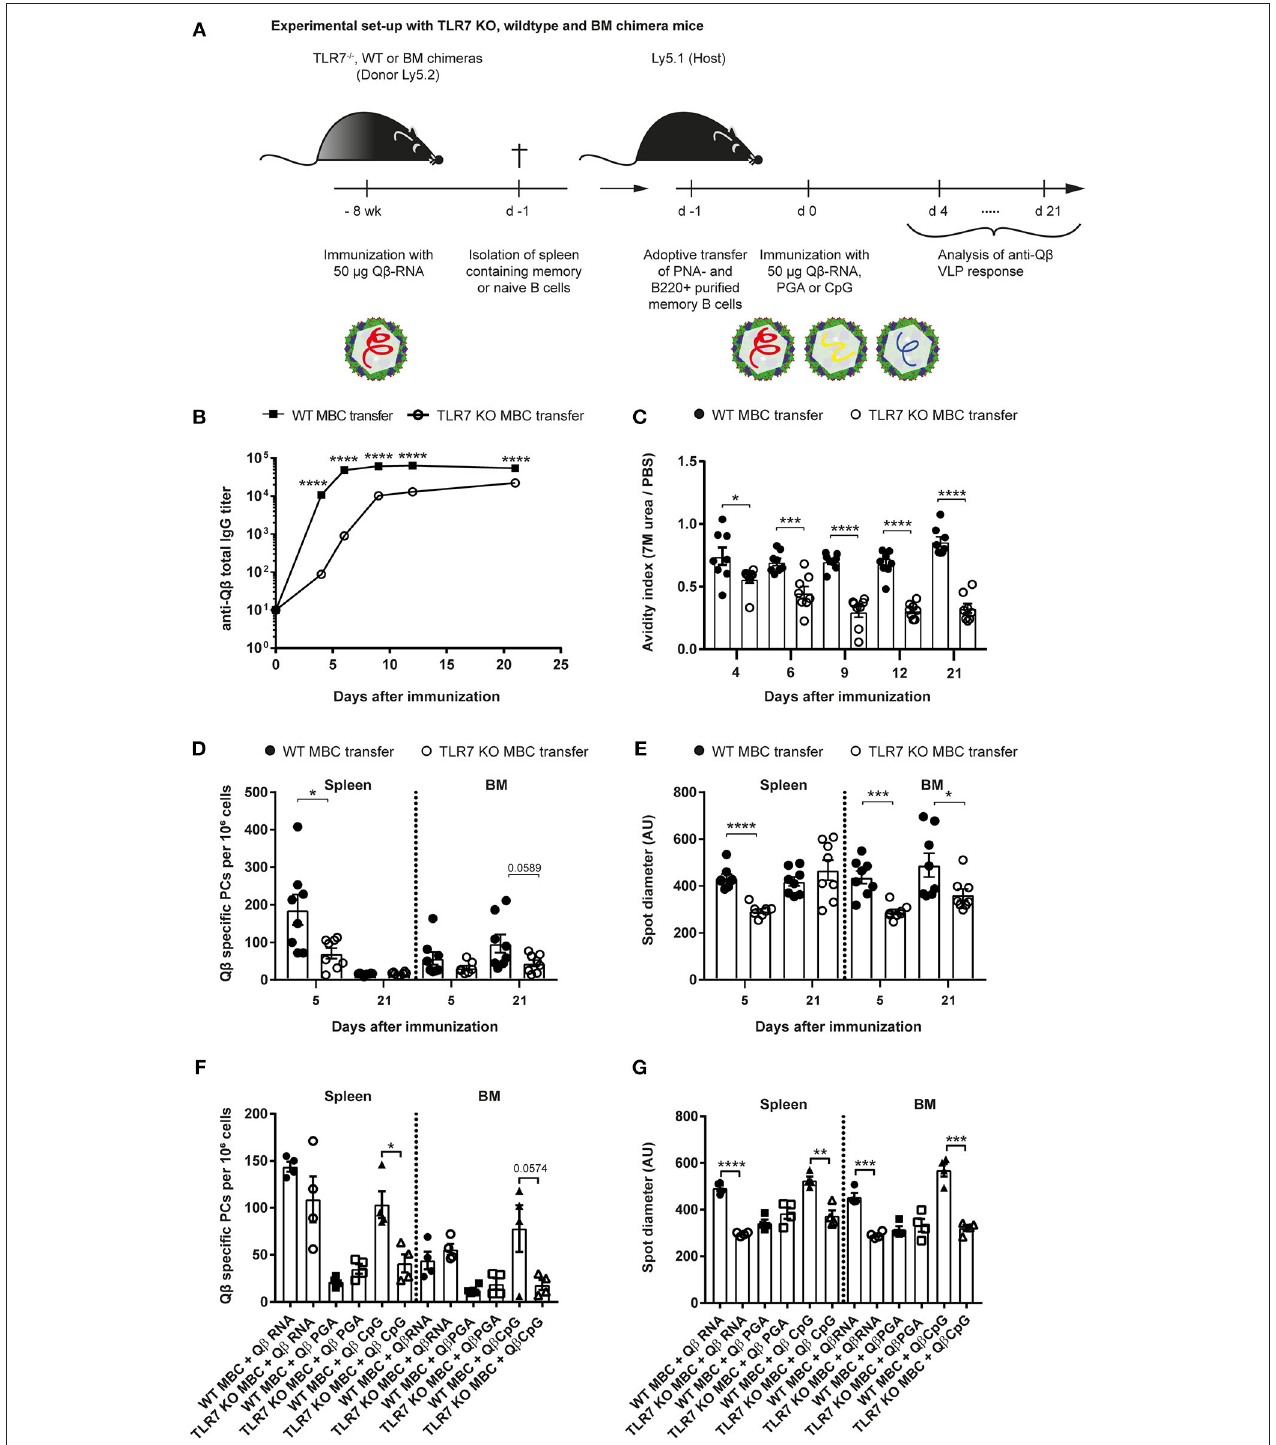
FIGURE 3 | TLR7 must be present during memory B cell induction to generate secondary PCs after challenge with VLPs. (A) Memory B cells were induced in TLR7 KO, WT, or BM chimeras by immunization with 50 µ g Q β -RNA i.v. Eight weeks after immunization spleens were isolated and PNA − B220 + MACS purified cells were transferred into host mice (Ly5.1). One day after the transfer, recipient mice were challenged with 50 µ g Q β -RNA (B–E) or Q β -RNA, Q β -PGA, and Q β -CpG (F,G) i.v. Spleens, bone marrow, and serum were taken at several time points after challenge. (B) Q β -specific total IgG titers after WT (black squares) or TLR7 KO (open circles) memory B cell transfer were determined by ELISA. (C) The avidity index after WT (black circles) or TLR7 KO (open circles) memory B cell transfer was determined by a